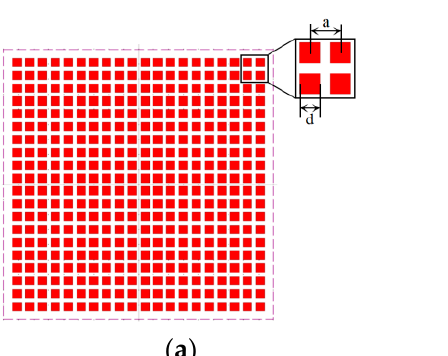
Figure 4. ( a ) Polarization beam splitting structure; ( b ) Energy band diagram of polarization beam splitting structure.